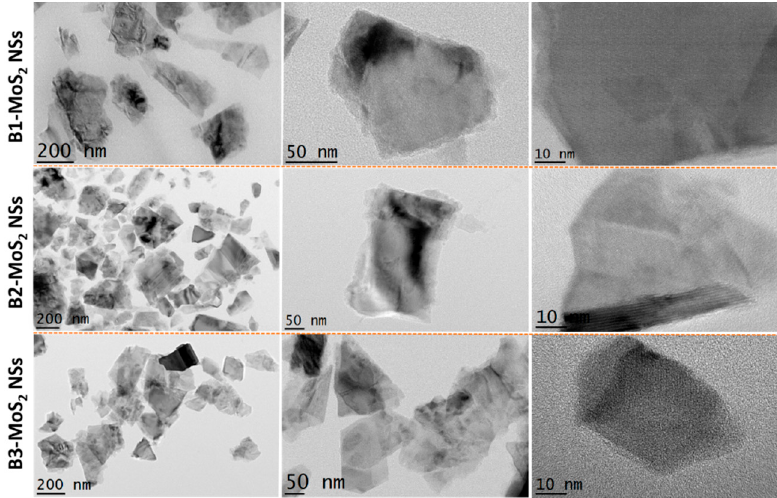
Figure 2. Low and high resolution TEM images of batch manner synthesized MoS2 NSs, such as B1- MoS2, B2-MoS 2 and B3-MoS 2 NSs . B1-MoS 2 , B2-MoS 2 and B3-MoS 2